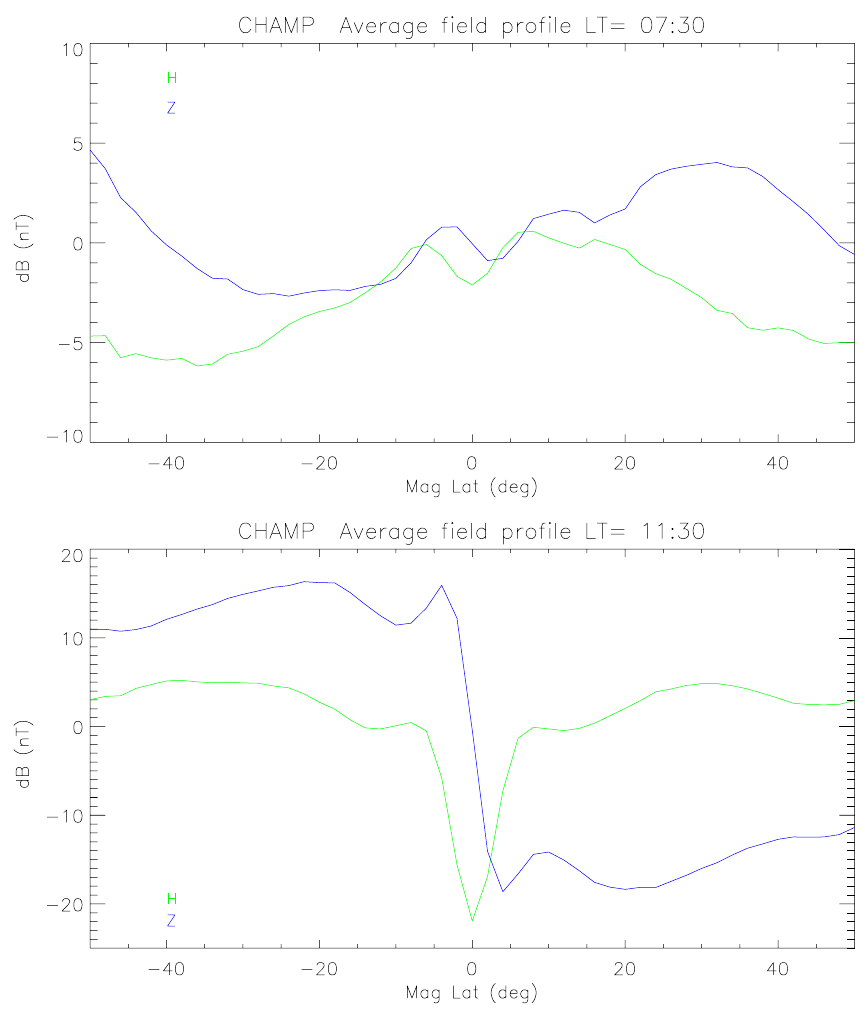
Fig. 4. Annual averages of the H and Z latitude profiles, as observed by CHAMP in the local time sectors = 07:30LT (top) and 11:30LT